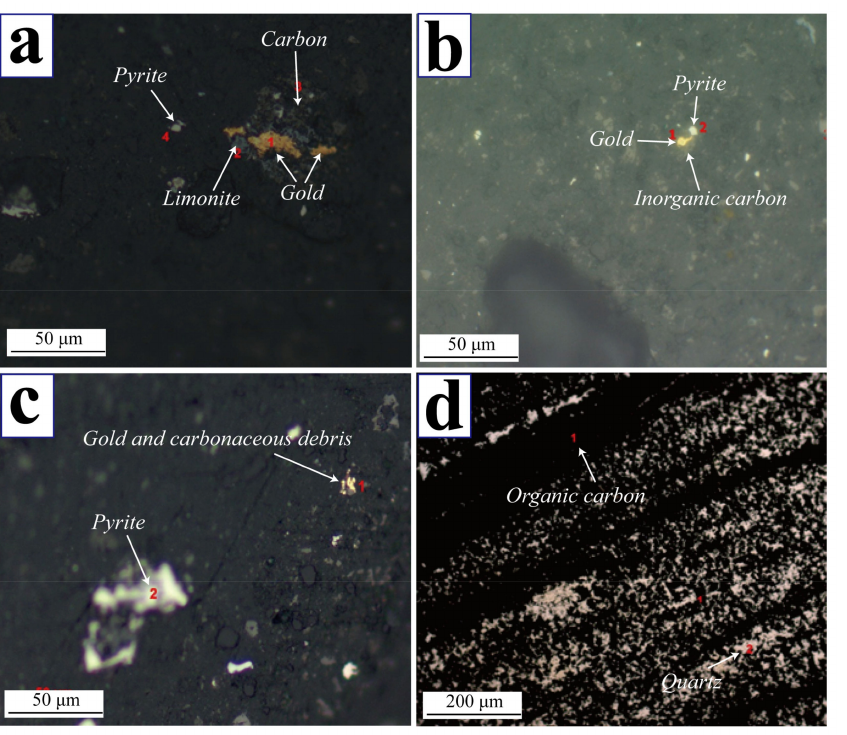
Figure 1. The process mineralogical analysis of raw ore. ( a ) The native gold is surrounded by limonite, carbonaceous and pyrite fragments; ( b ) Natural gold is associated with pyrite and carbonaceous; ( c ) Natural gold and carbon debris are symbiotic with each other; ( d ) The characteristics of carbon embedded